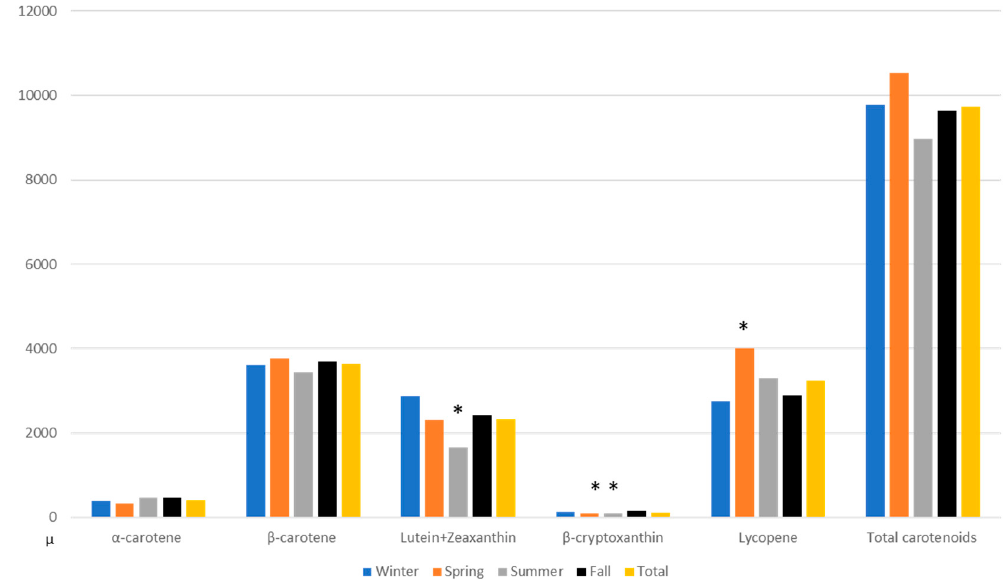
Figure 3. Using data from 24-HRs, comparison of fall intake of carotenoids ( µ g) with intakes during winter, spring and summer as well as with average of year round intakes ( n = 107). * The p -values for the comparisons are derived from a paired t-test.